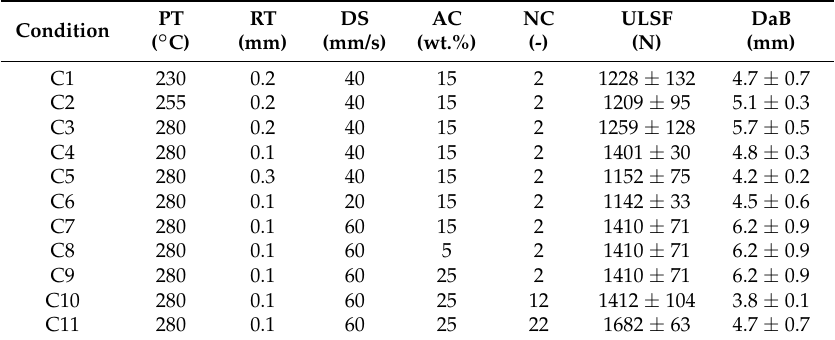
Table 4. Summary of the ULSF and DaB for all 11 conditions for ABS BM